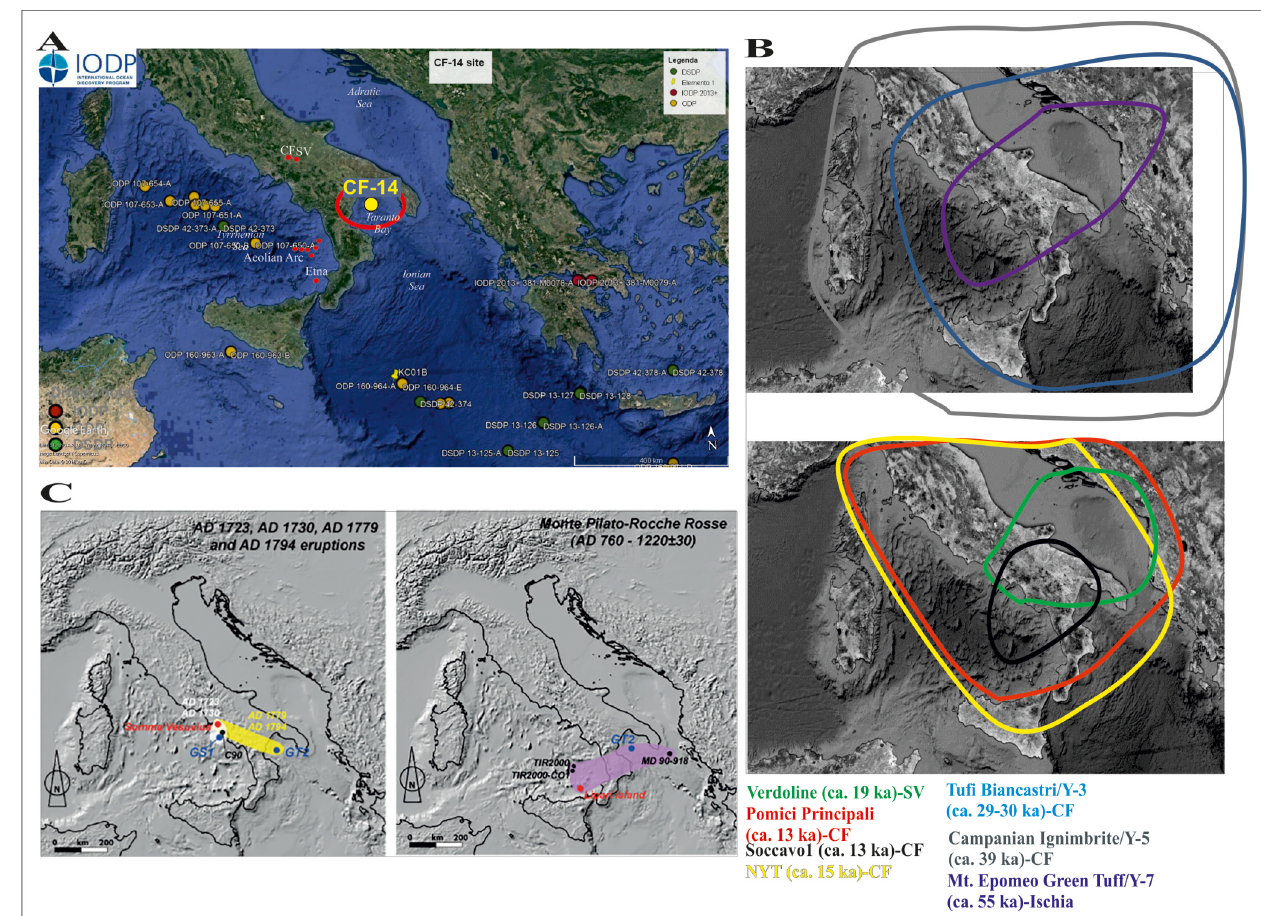
Figure 12. Proposed site CF-14 (Ionian Sea) for distal tephrostratigraphic reconstruction of Late Quaternary volcanism of the Campanian region (Crocitti et al., 2018; Di Donato et al., 2019). (a) Location map with an indication of the main DSDP (Deep Sea Drilling Project), ODP, and IODP archives (yellow for marine and green for terrestrial) of the central Mediterranean region; (b) dispersal maps of plinian and sub-plinian events (Bronk-Ramsey et al., 2015); (c) dispersal maps of moderately explosive eruptions (Sulpizio et al., 2014; Crocitti et al., 2018). Please note that the years given in AD in Fig. 12c correspond to those same years in the CE notation